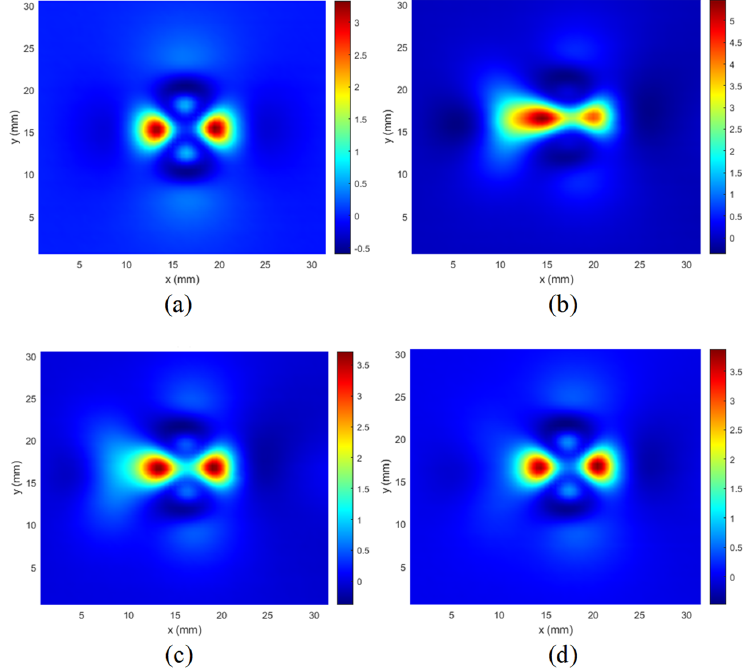
Figure 13. Comparison of C-scans: ( a ) achieved in case of the specimen without defect; ( b ) the specimens with the 5 mm long crack along the x -axis in the 1st layer; ( c ) in the 2nd layer; ( d ) in the 3rd layer.